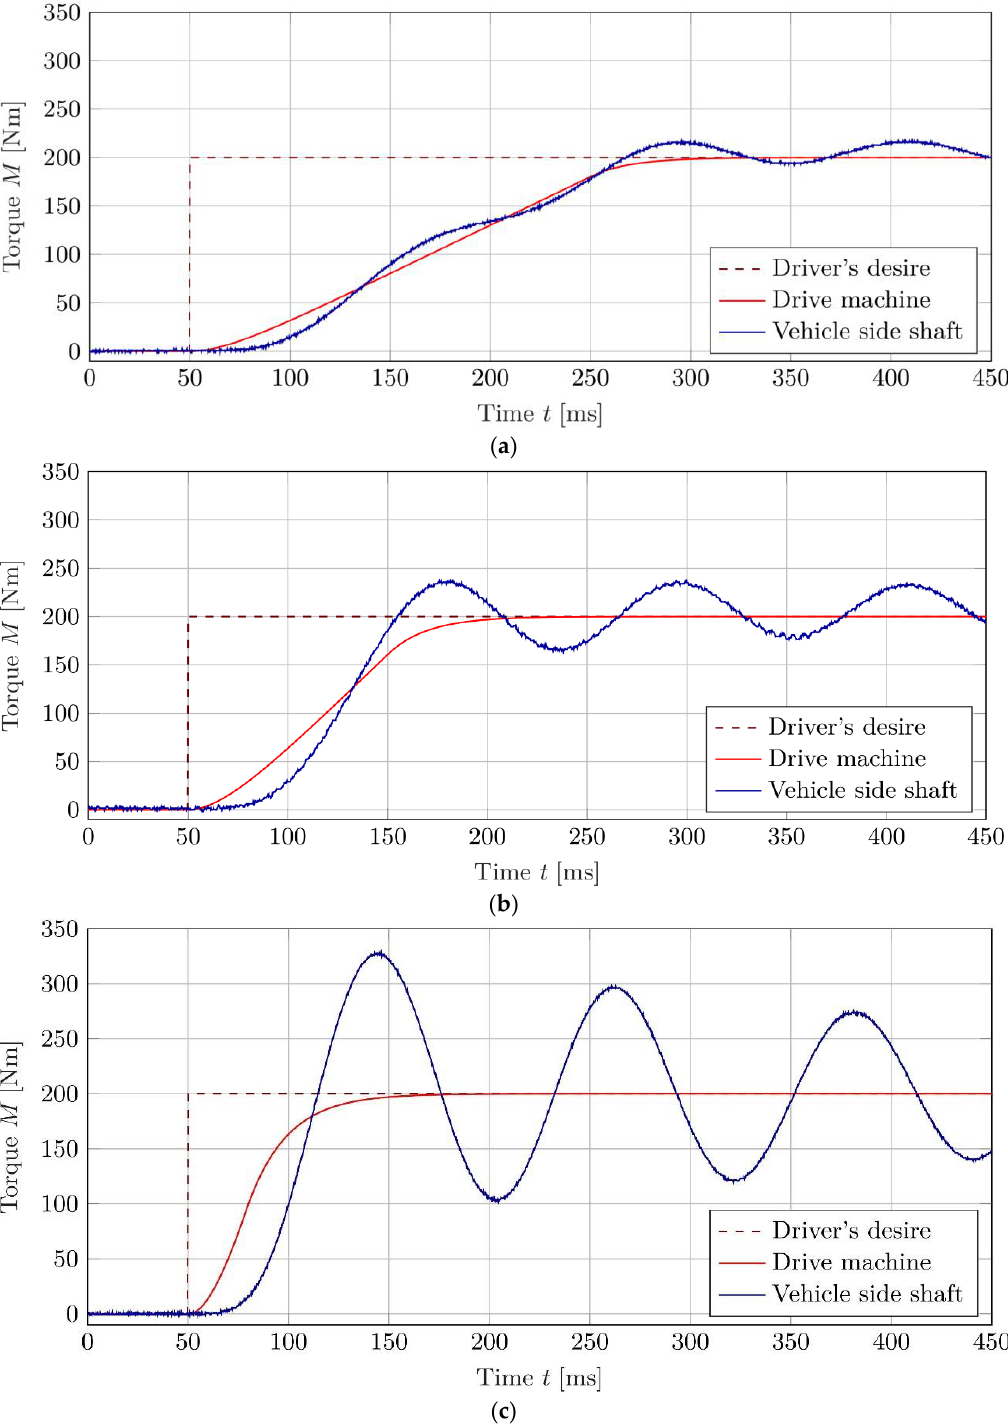
Figure 7. Torque curves as a result of the setpoint step in the driver′s desired torque without anti-jerk control with a gradient limitation of ( a ) 1000 Nm/s, ( b ) 2000 Nm/s, and ( c ) 7000 Nm/s while driving off.